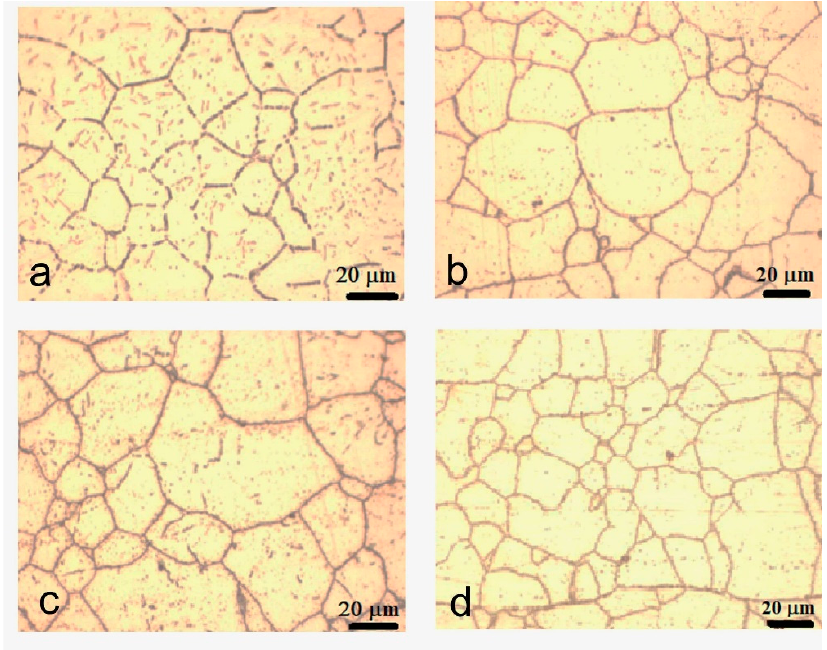
Figure 4. Microstructure for coated 310 H SS samples before ( a ) and after exposure in supercritical water for 720 h ( b ), 1440 h ( c ), and 2160 h ( d ) at 550 °C at magnifications of (500×).